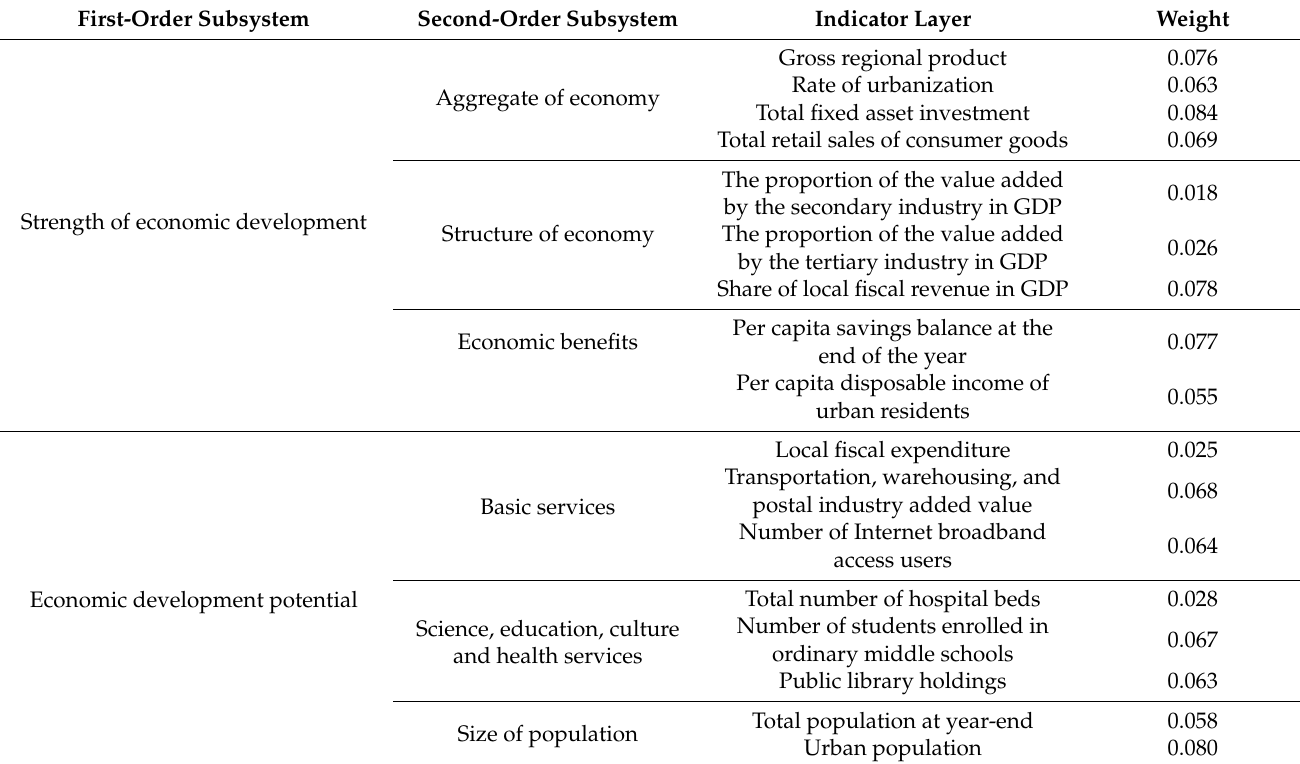
Table 2. Index system and weight of the urban comprehensive economic